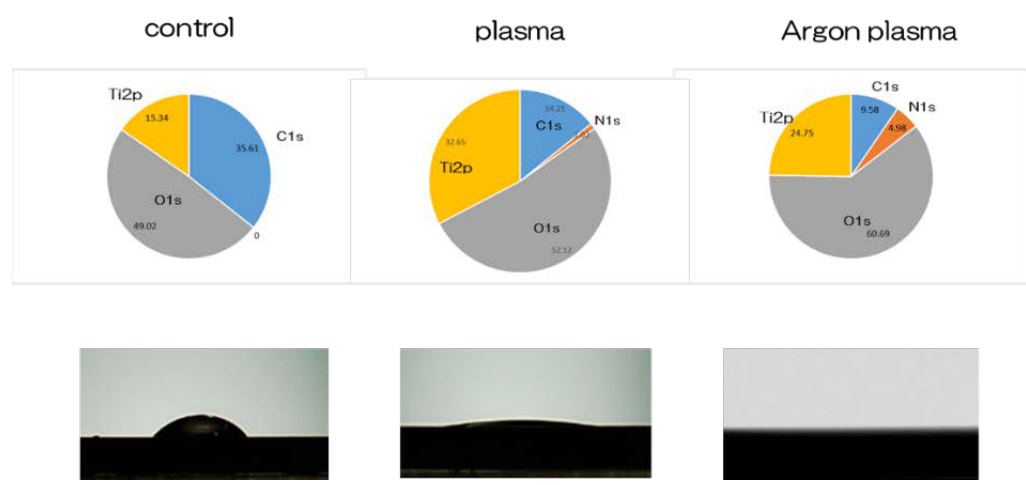
Figure 2. Based on the results of the X-ray photoelectron spectroscopy (XPS) analysis, an increase in the O 2 peak on the titanium surface was observed due to plasma treatment. In contrast, the C1s peak height on the titanium surface was decreased due to the plasma treatment. The C1s peak showed the lowest value in the argon plasma-modified group. It was clarified that the contact angle of the material surface was reduced due to plasma treatment; this was the lowest value in the argon plasma-modified group. The untreated group showed 62°, the plasma-treated group showed 8°, the argon gas group showed 0°, and the argon gas group showed the lowest value.